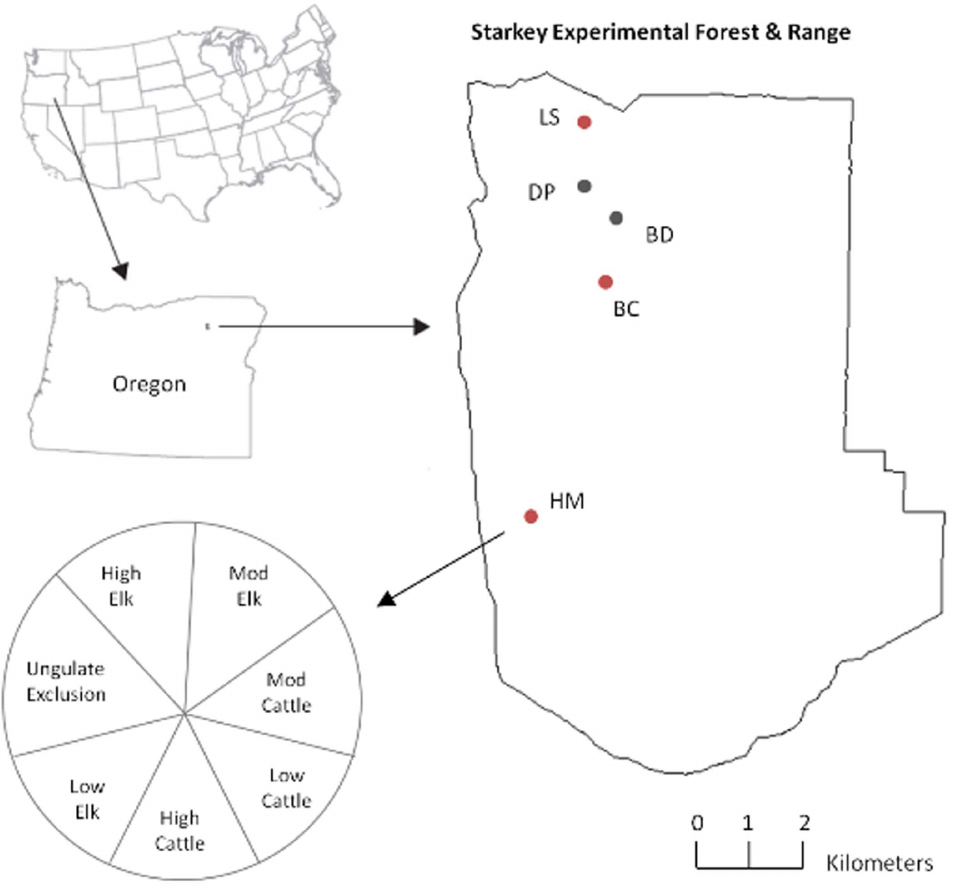
Figure 1. Location and design of ungulate browsing treatments at five sites at the Starkey Experimental Forest and Range in northeastern Oregon. Fuels treated sites are indicated with red dots and non-fuels treated sites in gray dots.